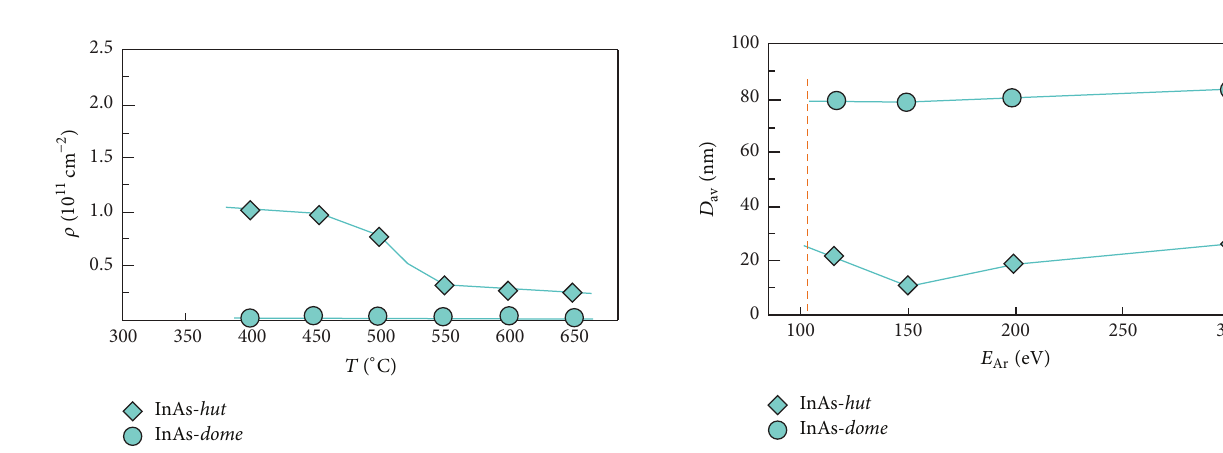
Figure 10: Average size of InAs nanoislands as a function of ion energy.